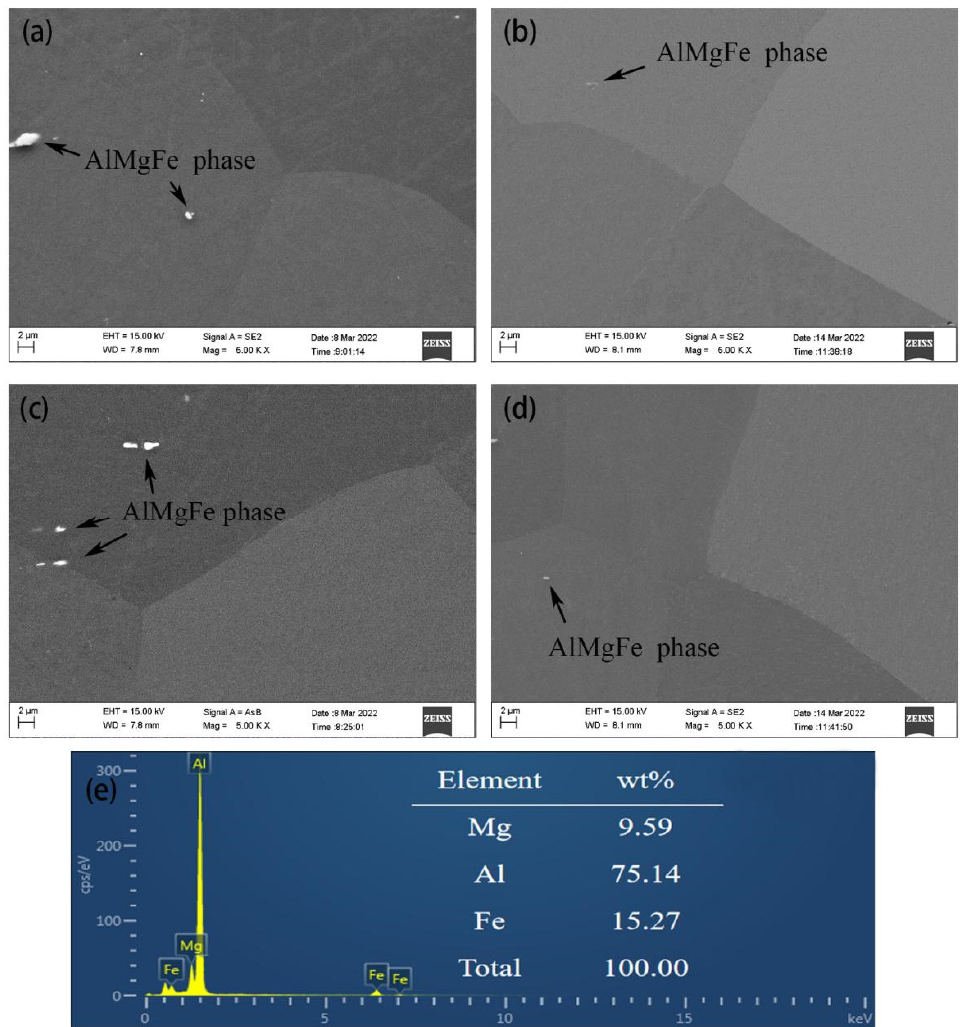
Figure 3. SEM images and EDS results of the Al-(2.86~9.41) Mg alloy sheet ( a ) x = 2.86% Mg; ( b ) x = 4.23% Mg; ( c ) x = 6.51% Mg; ( d ) x = 9.41% Mg. ( e ) the result of EDS analysis of Al Mg Fe phase in the Al-4.23 Mg alloy sheet.